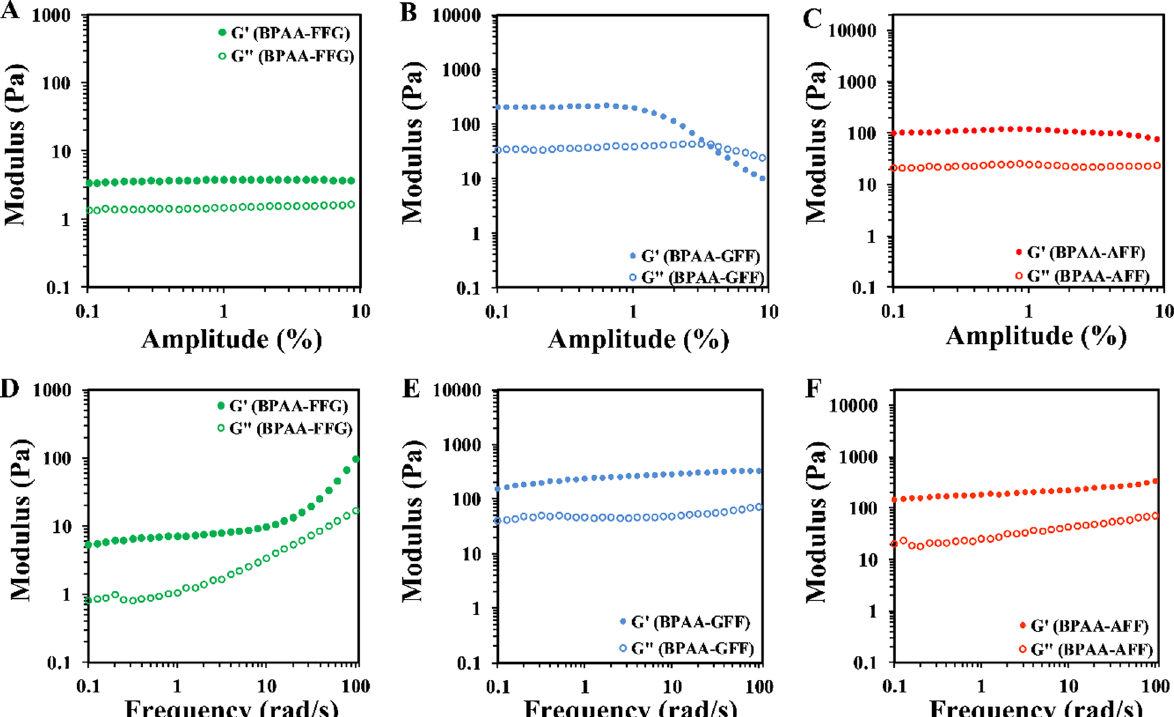
Fig. 4 A – C Amplitude sweep analysis of BPAA-FFG, BPAA-GFF and BPAA-AFF hydrogels (Frequency BPAA-FFG, BPAA-GFF and BPAA-AFF hydrogels (Strain